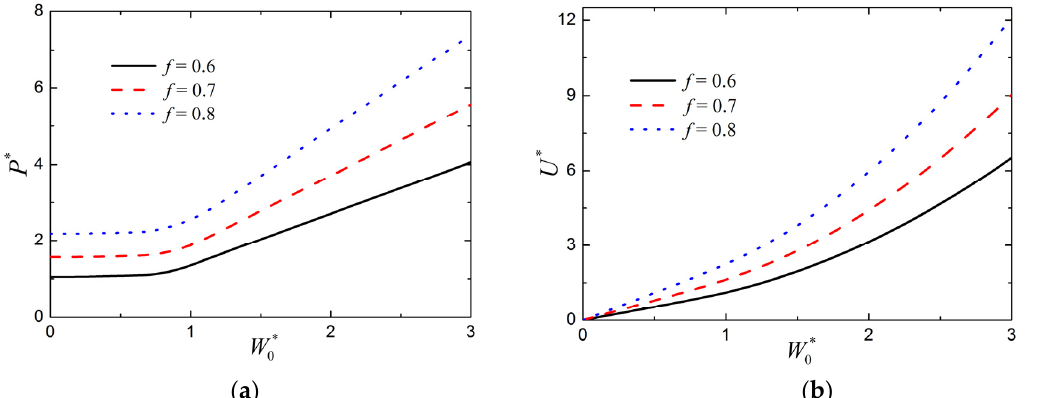
Figure 7. Influence of metal volume fraction f on the large deflection response of FML sandwich beams transversely loaded by a flat punch ( c = 0.03, a = 0.05, h f = 0.05, σ c = 0.1, n = 3, q = 2): ( a ) Load versus midspan deflection; ( b ) absorbed energy versus midspan deflection.